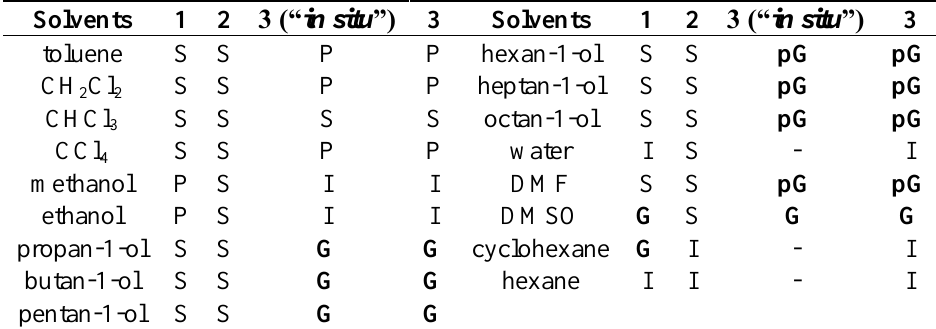
Table 1. Gelation tests (2%